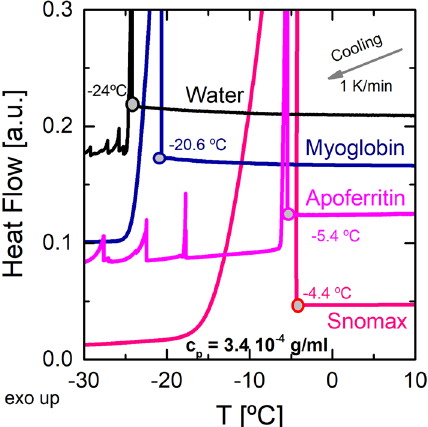
Figure 5. Heat Flow (each curve set off for clarity) as a function of the temperature, for pure water, and for aqueous solutions of apoferritin, Snomax, and myoglobin (all protein concentrations 3.4 10 −4 g/ml). The crystallization temperatures are indicated in the plot. Apoferritin shows additional crystallization or re-crystallization processes at lower temperatures. Created with OriginPro 9.0 (www. origi nlab. com/).